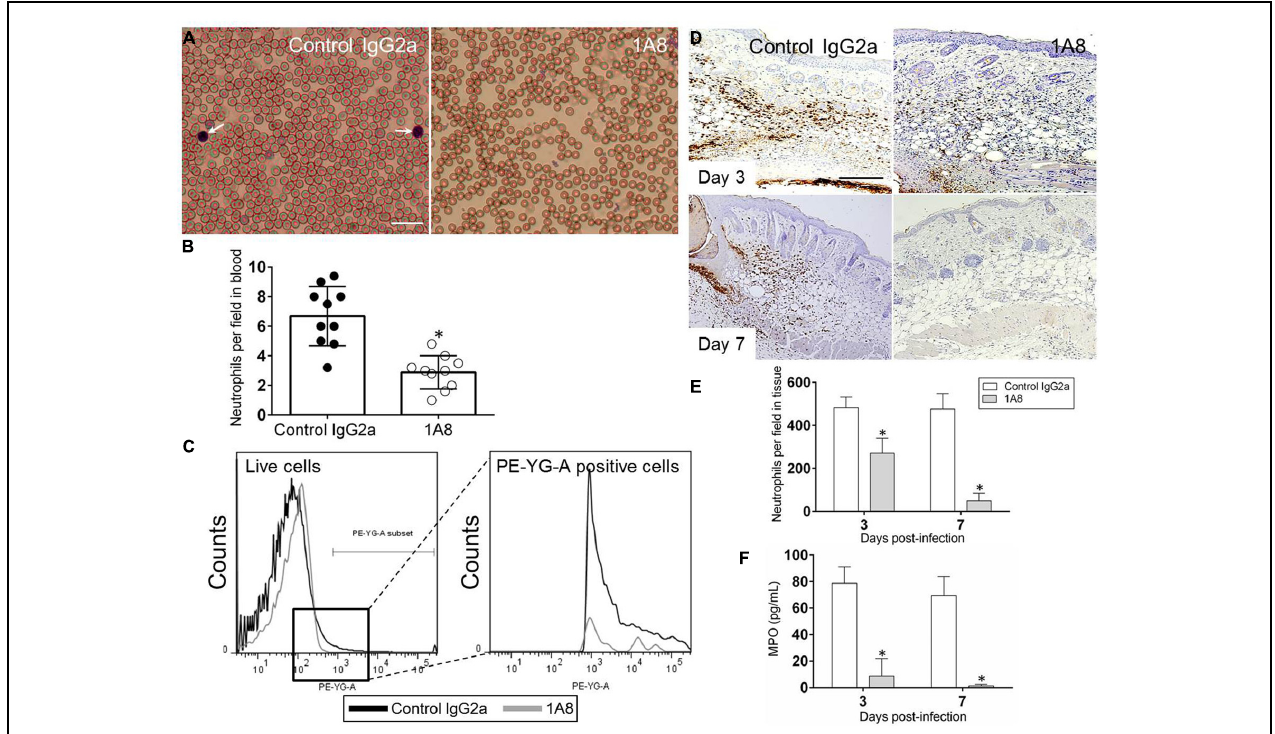
FIGURE 1 | MAb 1A8-treated animals display a low number of blood and skin tissue neutrophils. (A) Light microscopy images of blood smears from control (isotype-matching IgG2a) or mAb 1A8-treated (1A8) mice pre-infection. Pictures were taken 3 days post-injection. Arrows indicate neutrophils. Scale bar: 20 μ m. (B) Number of neutrophils per field in blood of irrelevant (control IgG2a) or 1A8-treated mice quantified 3 days post-injection. Each black or white circle represents the numbers of neutrophils per individual field. Bars and error bars denote average of ten counts and standard deviations, respectively. Asterisks denote P -value significance ( ∗ P < 0.05) calculated using student’s t -test analysis. The experiment was performed thrice with similar results obtained. (C) The expression levels of the Ly-6G + cells were analyzed by flow cytometry 3 days post-injection and a representative graph is shown. Primary cells were isolated from blood of animals ( n = 5) injected with irrelevant or mAb 1A8. The experiments were performed twice with similar results obtained. (D) Immunohistochemistry (IHC) of myeloperoxidase (MPO) released by neutrophils in wounds removed from control IgG2a and 1A8-treated mice. MPO-specific monoclonal antibody (mAb) was used to stain MPO (brown)